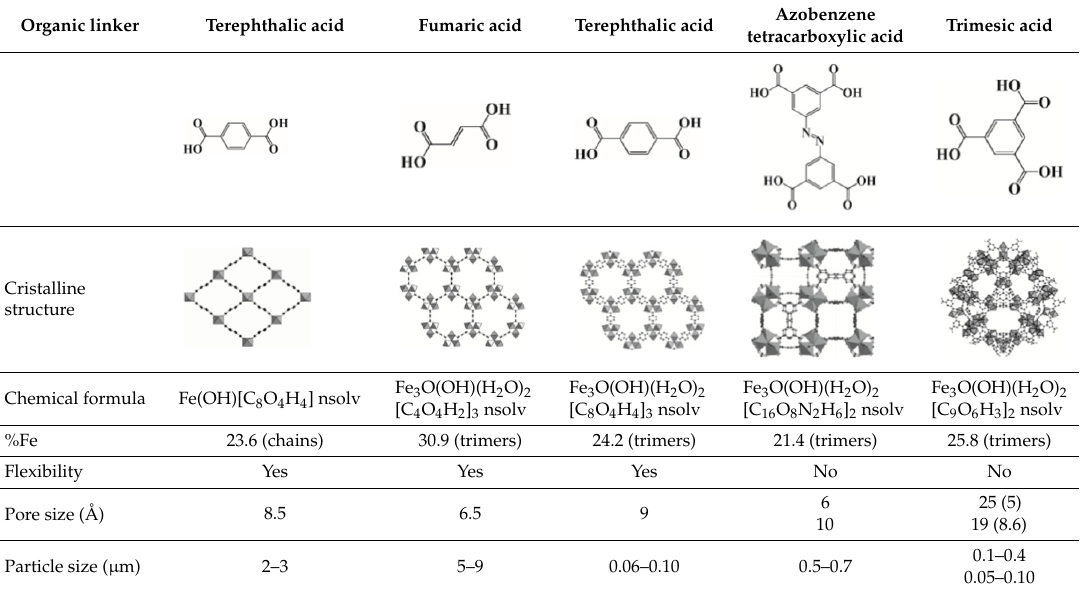
Table 1. Porous iron(III)-based metal–organic frameworks (MOFs) employed as cationic promoted photoinitiators.